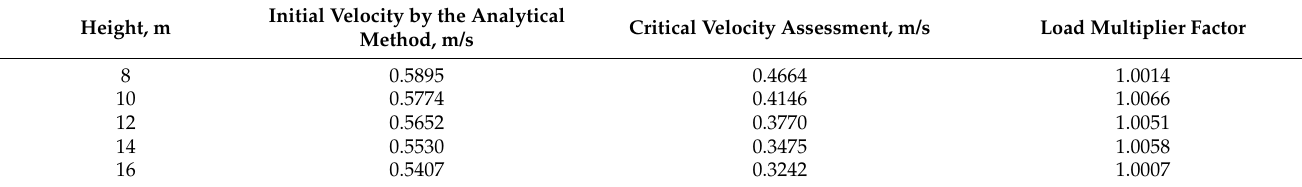
Table 9. The effect of cage height on the critical velocity, for the Holding State.